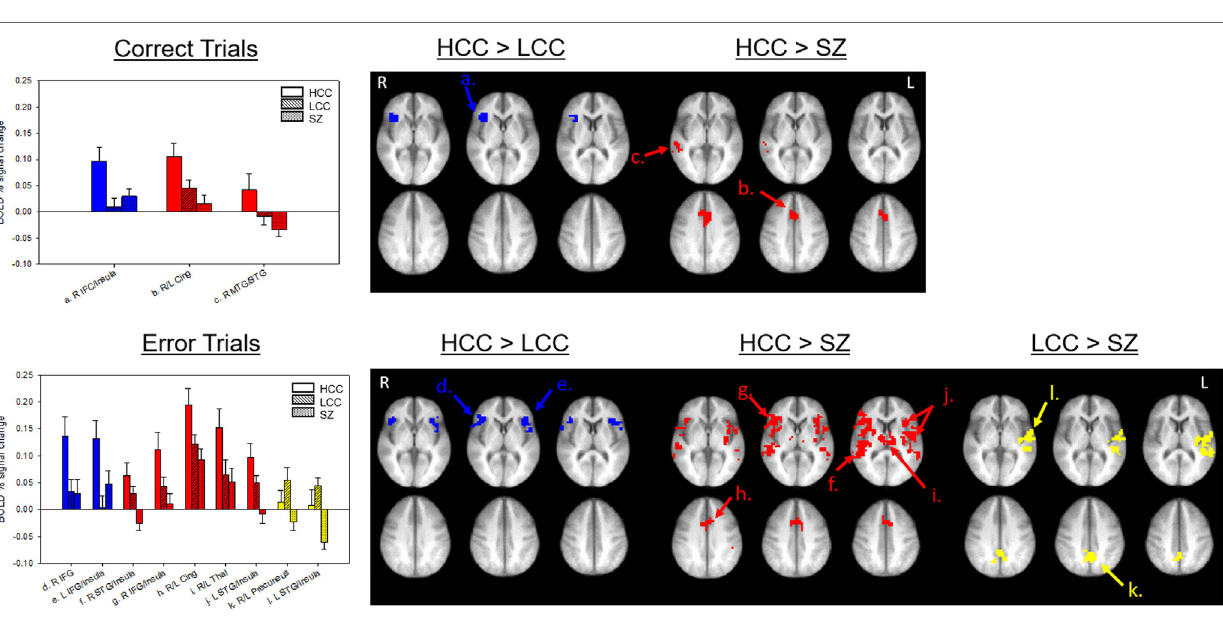
FigUre 4 | Group-wise differences in antisaccade activation. Top panel shows group-wise differences in antisaccade correct trial activation. Bottom panel shows group-wise differences in antisaccade error trial activation. Bars (SE) show levels of activation for each group in each labeled cluster from Table 2 . Clusters are shown on an anatomical image averaged across all subjects in Talairach space (top z = 2, 6, 10; bottom z = 31, 35, 39) I radiological orientation. Colors indicate in which comparison the cluster was significant. HCC, high cognitive control; LCC, low cognitive control; SZ, schizophrenia; IFG, inferior frontal gyrus; MTG, middle temporal gyrus; STG, superior temporal gyrus.